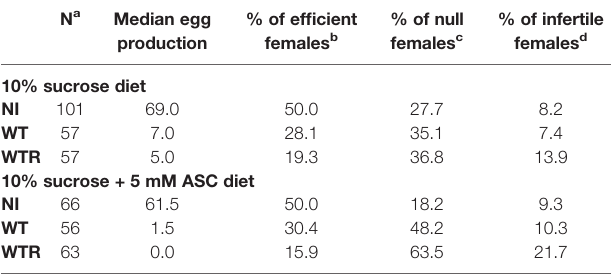
TABLE 1 | Oviposition ef fi ciency of A. aegypti females infected with S. culicis strains in the presence or not of ASC-enriched diet. N a Median egg